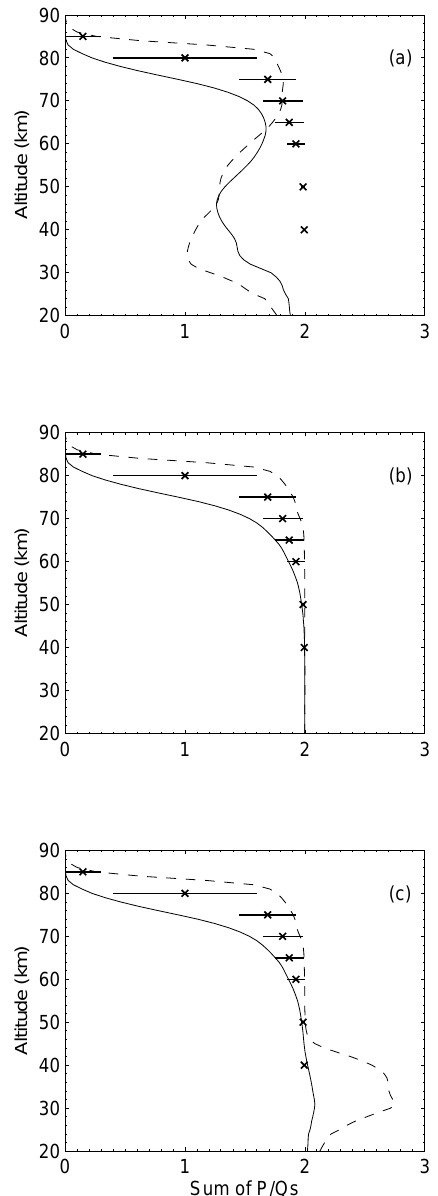
Fig. 5. Comparison of P/Q numbers: SIC results (January NH and SZA=105 ◦ ) versus Solomon et al. (1981, Fig. 2). The Solomon et al. data for Q = 10 3 cm − 3 s − 1 are marked with X, and the cor- responding horizontal lines indicate the variability with respect to Q = 10 1 –10 5 cm − 3 s − 1 . The same data are shown in all three pan- els. SIC results: (a) OH and H production only; (b) OH, H, HNO 2 , and HNO 3 production, excluding N 2 O 5 -to-HNO 3 conversion; and (c) OH, H, HNO 2 , and HNO 3 production, including N 2 O 5 -to- HNO 3 conversion. The dashed and solid lines indicate results for Q = 10 1 and 10 5 cm − 3 s − 1 ,